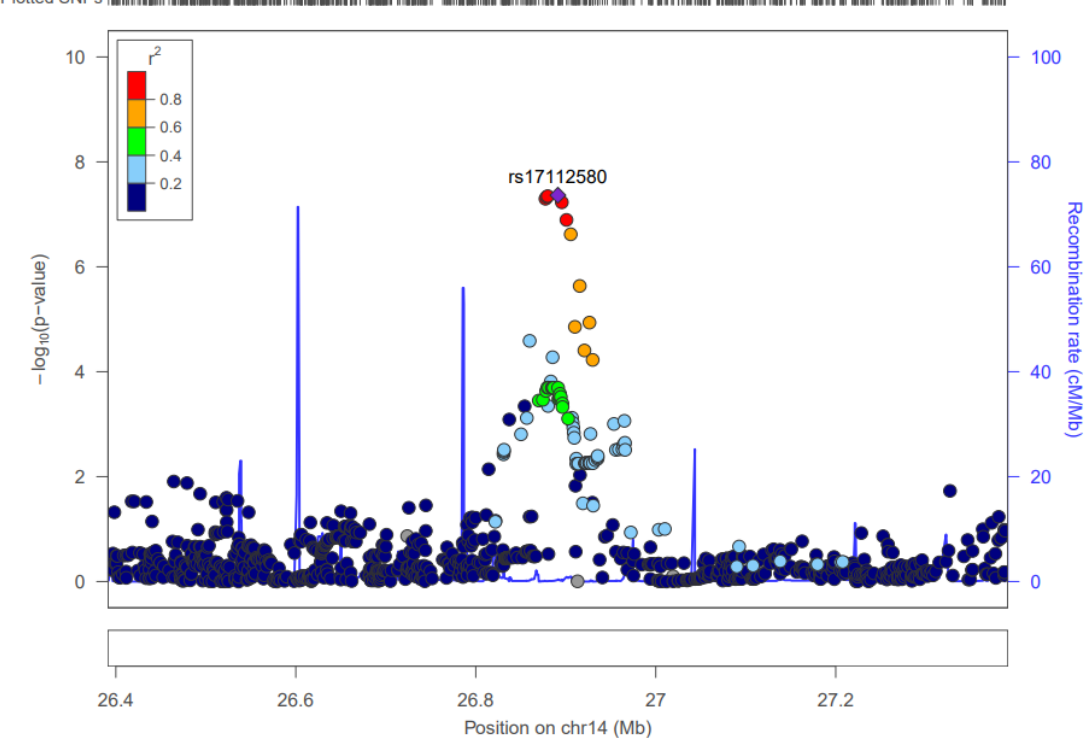
Figure 4. LocusZoom Plot for rs17112580. Note: Start-stop positions for CTD-3006G17.2 are